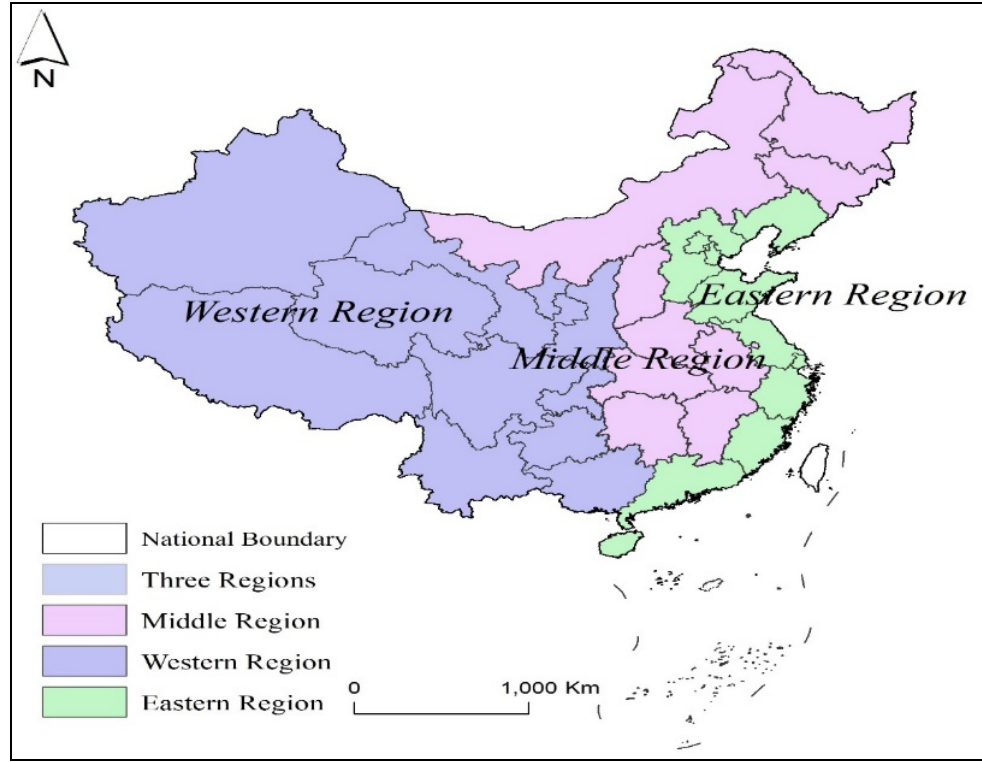
Figure 1. The geographical division of China.